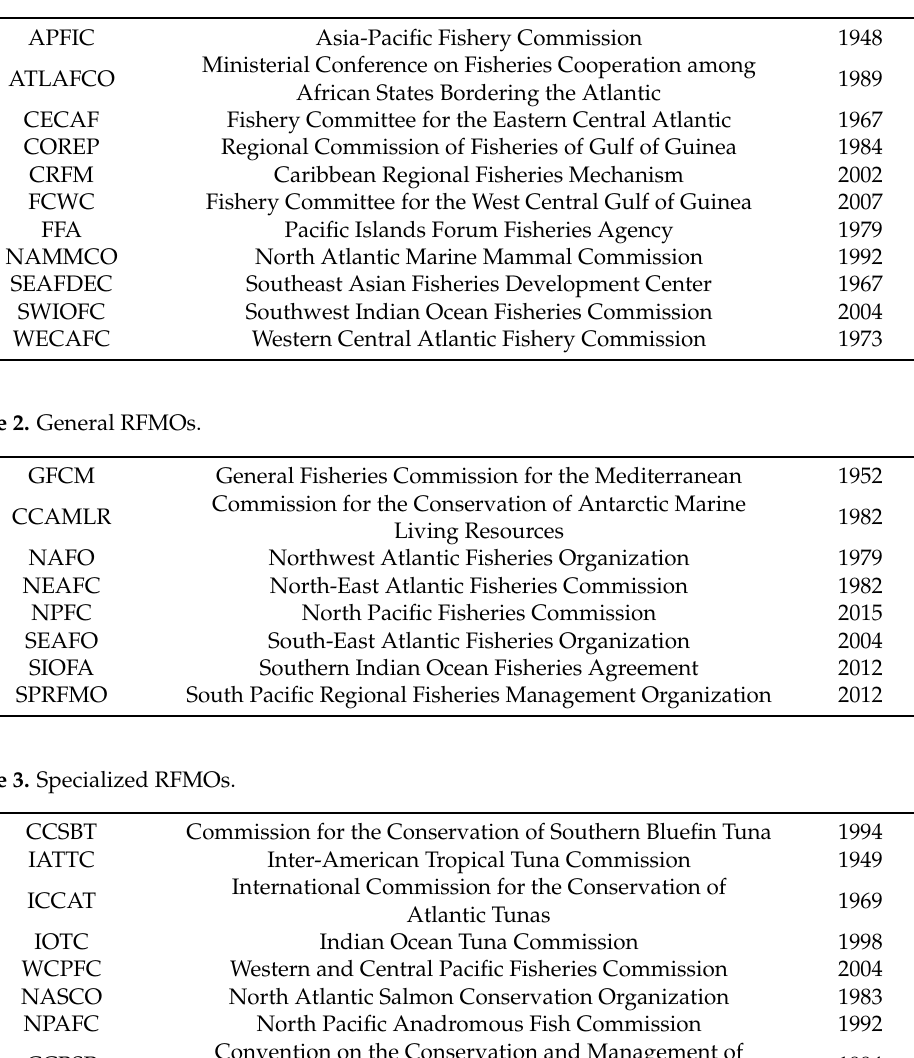
Table 1. Some Important RFABs.